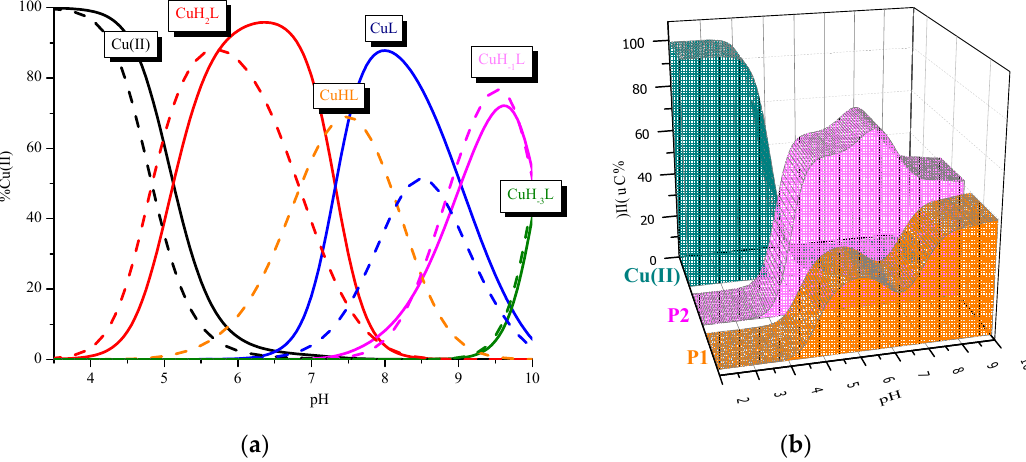
Figure 4. ( a ) Comparison of species distribution curves between Cu(II)/P1 (solid line) and Cu(II)/P2 (dashed line), ( b ) Comparison of the P1/Cu(II)/P2 systems. The ligands concentrations were 7×10 −4 mol/L and pH-metric titrations were performed in a 0.3 mol/L KCl solution using sample volumes of 1.5 mL. Measurements were carried out in a 2.5–10 pH range, at 25 °C. The ligand to metal ratio was 2:1.